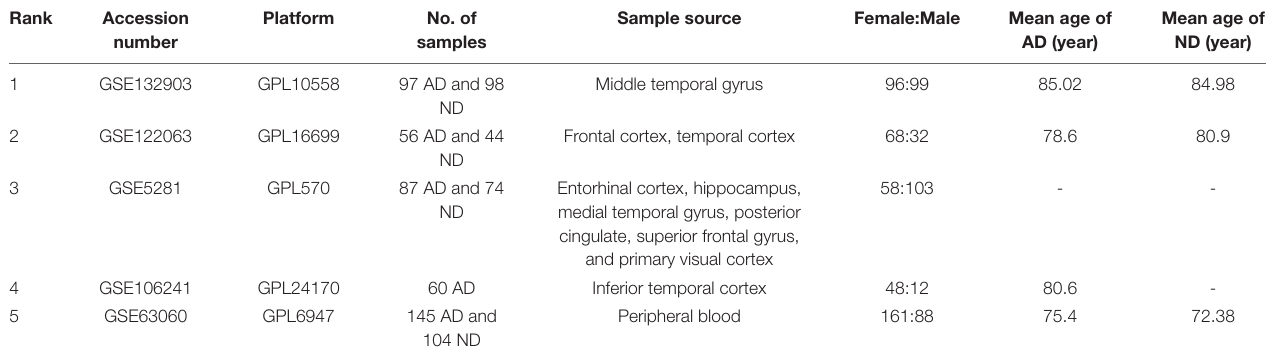
TABLE 1 | The details of the selected